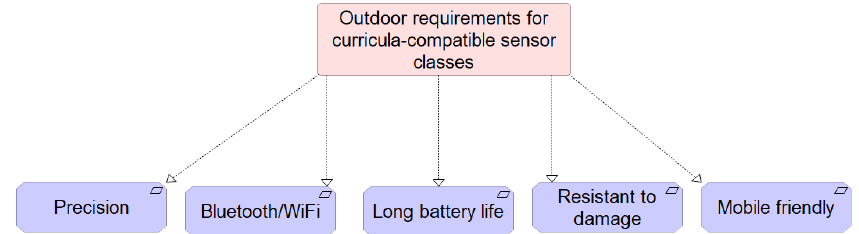
Figure 8. Requirements for outdoor curricula-compatible